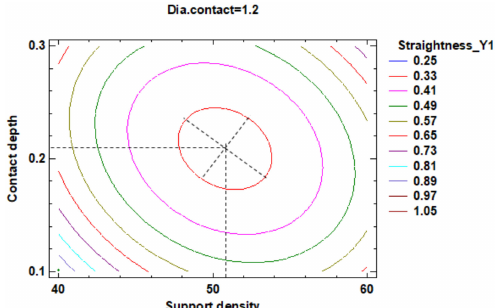
Figure 22. Contours of Estimated Response Surface for Straightness_Y1 and centre diameter contact.